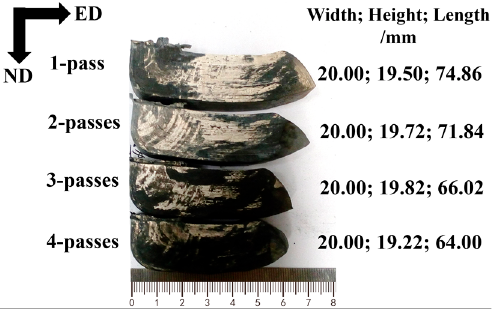
Figure 2. Photographs of ECAPed samples at 400 °C for different passes.